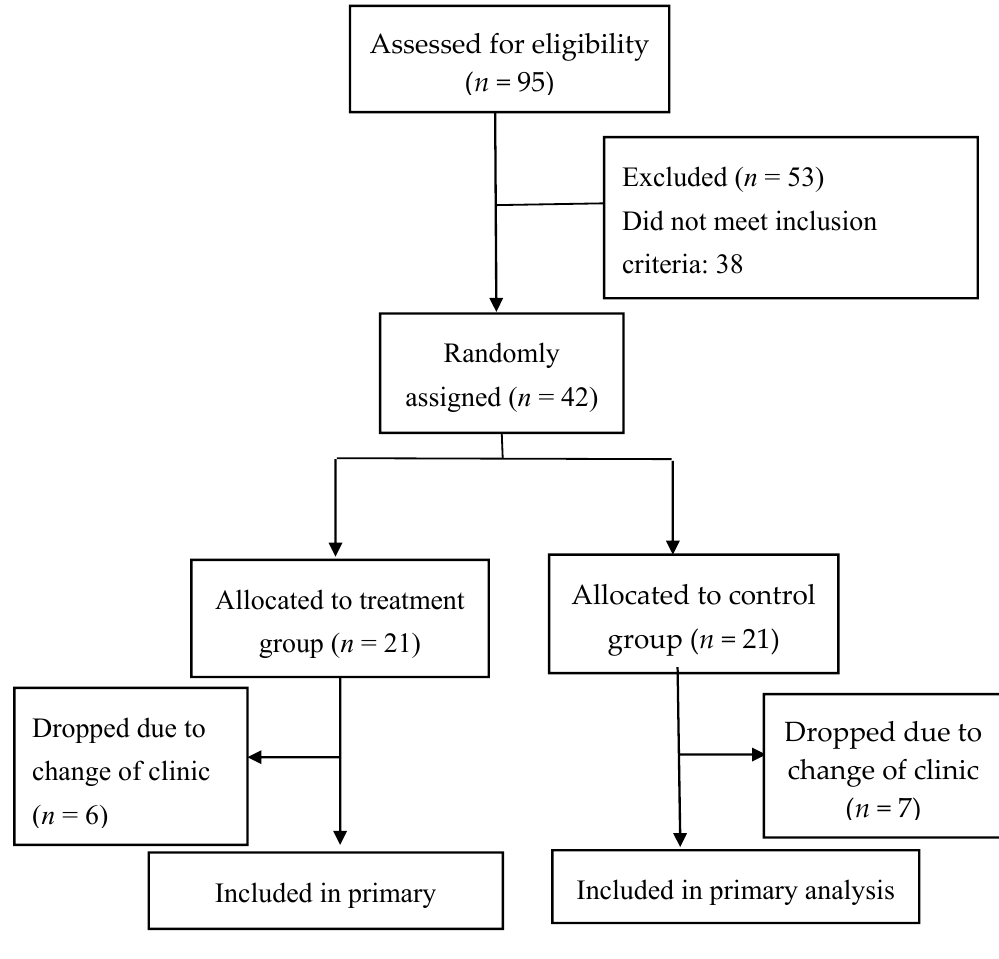
Figure 1. Study flow diagram.